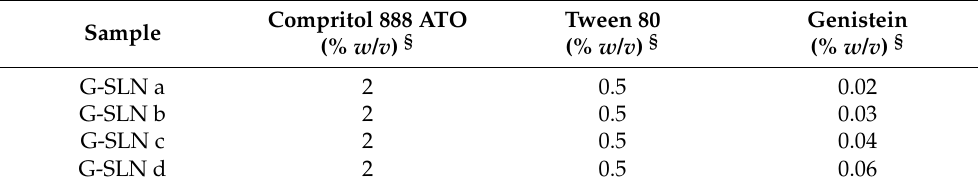
Table 1. Composition of Genistein (GEN)-loaded solid lipid nanoparticles (SLN).